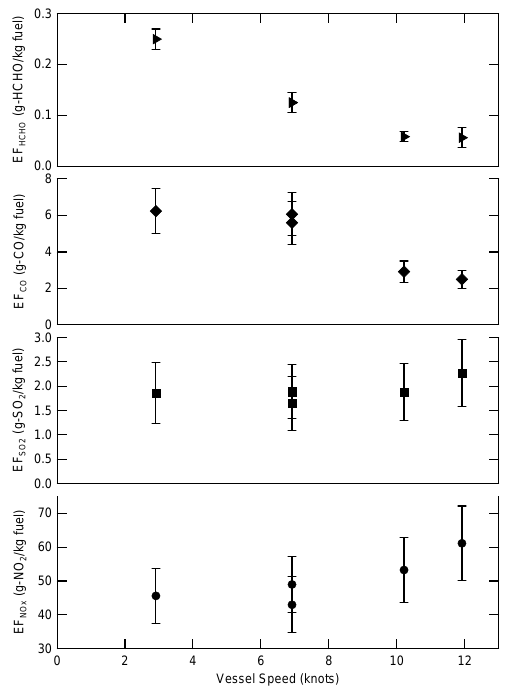
Fig. 6. Emissions factors (in g per kg fuel) for primary organic mat- ter (POM) or primary organic carbon (POC) as a function of the vessel speed ratio for multiple studies (A) normalized to 85% load and (B) as absolute values. The speed ratio is the ratio between the operating speed and the maximum ship speed, and for the test-rig and stack-sampling studies was estimated from the reported engine load using the propeller law. The symbols in the legend indicate which studies were performed on the same engine or ship. The leg- end names indicate the study, reported parameter (POM or POC), engine type (MSD or SSD) and fuel type (HFO or low-sulfur, in- cluding biofuels, MDO and MGO). The downward green arrow in- dicates that the actual EF reported for this point was actually zero.